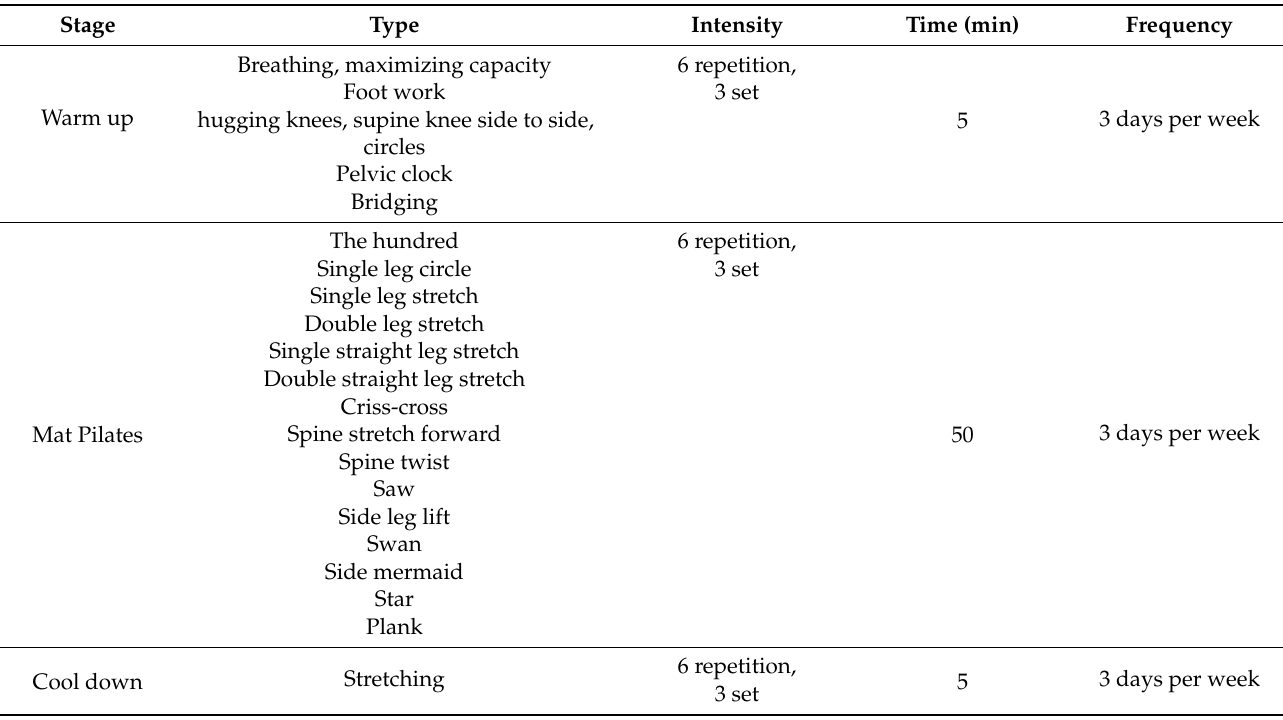
Table A3. The Pilates program.